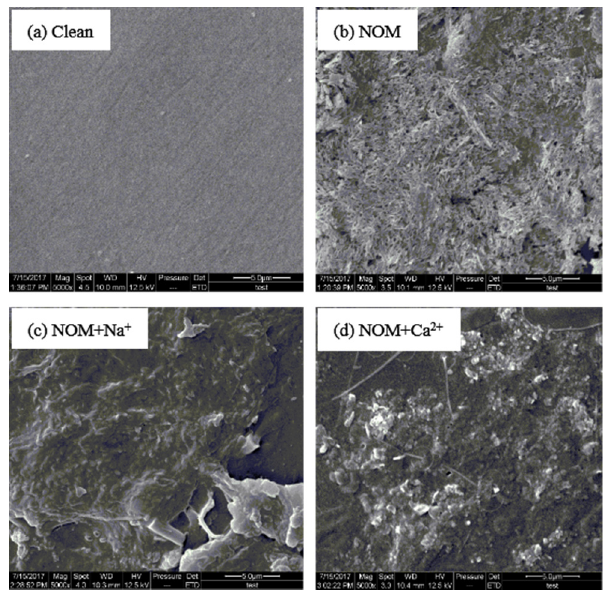
Figure 7. SEM images of fouled membranes after filtering reconstituted NOM solutions. ( a ) Control; ( b ) NOM; ( c ) NOM + NaCl; ( d ) NOM + CaCl 2 .